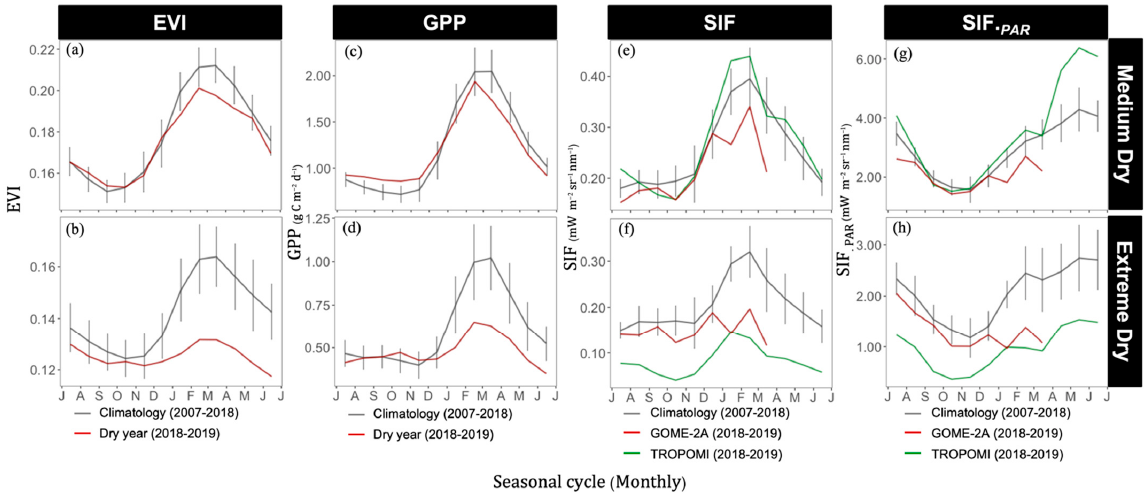
Figure 4. The spatially averaged seasonal cycles of monthly EVI, GPP, SIF, and SIF PAR within ( a , c , e , g ) medium and ( b , d , f , h ) extreme dry extent from July 2018 to June 2019. The grey curves represent the monthly multiyear mean (2007–2018). Vertical lines refer to ±1 standard deviation.